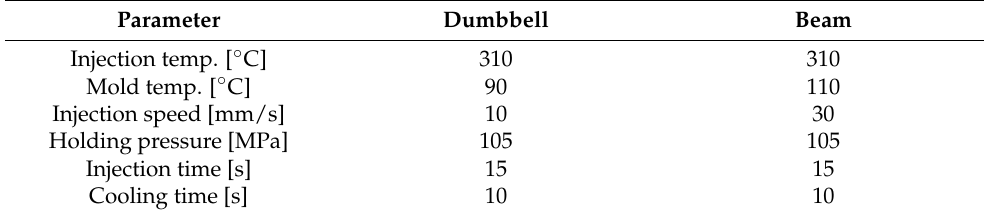
Table 2. Injection molding